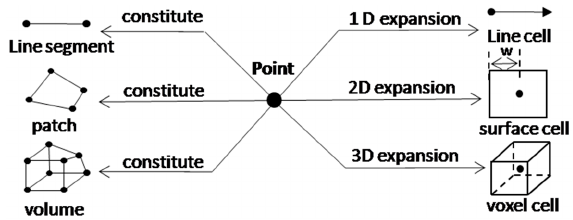
Figure 1. Roles of a point in a spatial sampling particle.